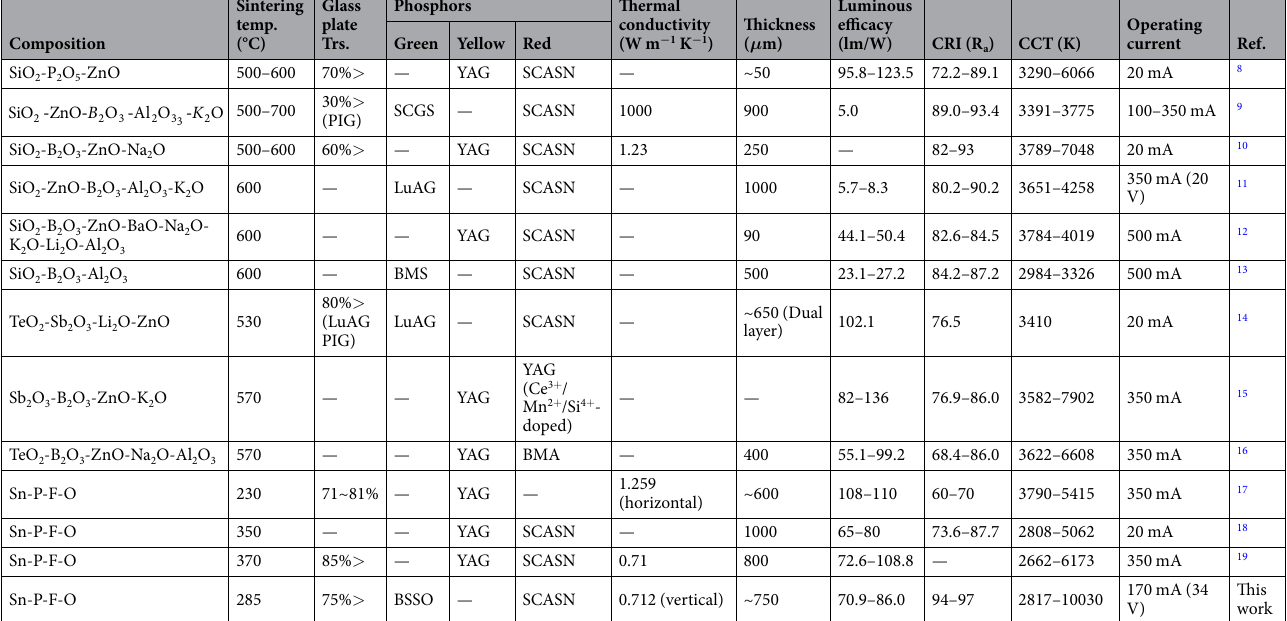
Table 1. Summarization table of dual-phosphor based and/or low-temperature sintered PIG-type WLEDs in previously reported works. (Abbreviations: YAG = Y 3 Al 5 O 12 :Ce 3 + , SCASN = (Sr x Ca 1 − x )AlSiN 3 :Eu 2 + ,